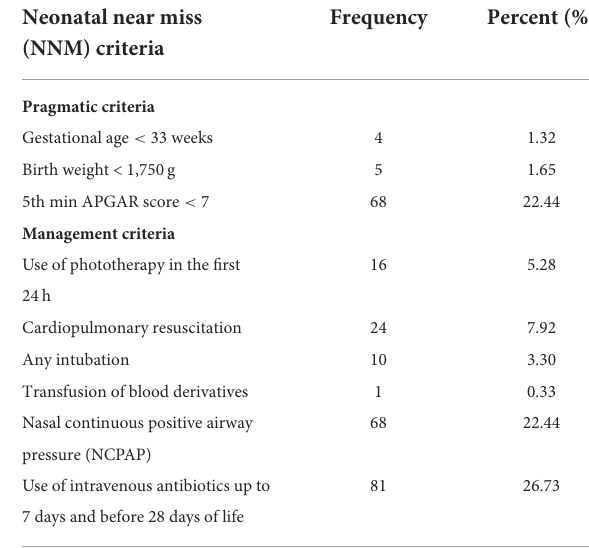
TABLE 4 Maternal complication during labor and delivery among mothers of neonates admitted ( n = 303) to public hospitals of Ilu Abba